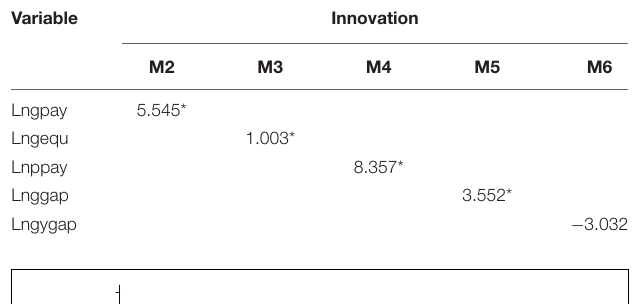
TABLE 4 | Multiple regression results of salary, salary gap, and enterprise innovation efficiency. Variable